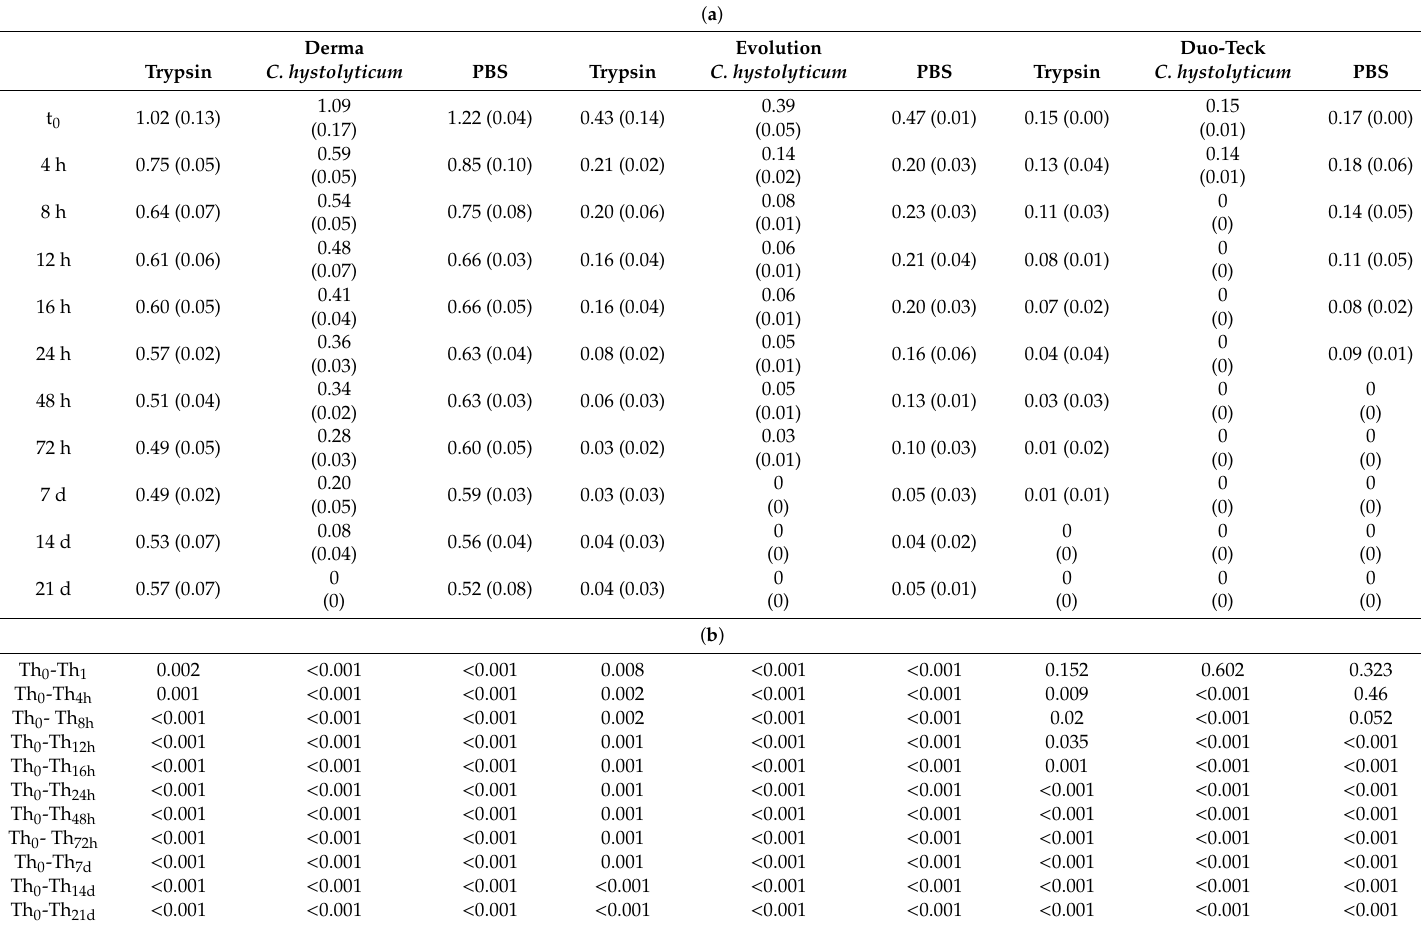
Table 1. ( a ) Thickness (mm) analysis of the three experimental membranes (Derma Fina, Evolution Standard and Duo-Teck) after immersions periods up to 21 days in PBS (Hydrolytic degradation test), collagenase from Clostridium histolyticum (Bacterial collagenase resistance test) and trypsin (Enzyme resistance test). Values shown are mean and standard deviation. ( b ) Attained p values after pairwise comparisons between membranes’ thicknesses after the di ff erent immersion times and the initial thickness (thickness at t 0 : Th 0 ). Significance was considered at p ≤